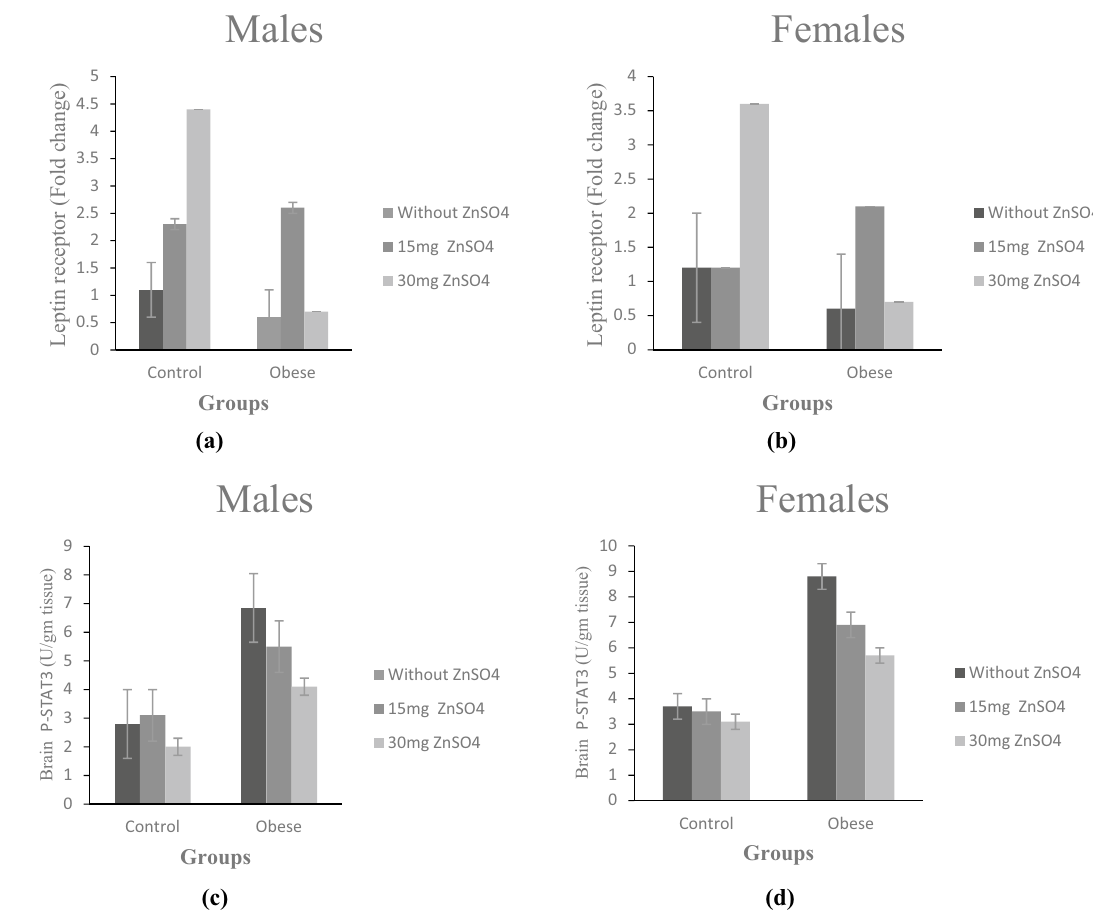
Figure 3. ( a , b ) Fold change in leptin receptor expression in brain tissue in control and obese groups; without ZnSO 4 , 15 mg ZnSO 4 , and 30 mg ZnSO 4 in male and female rats, respectively. ( c , d ) Brain tissues levels of p-STAT3 (U/gm tissue) in control and obese groups; without ZnSO 4 , 15 mg ZnSO 4 , and 30 mg ZnSO 4 ; in male and female rats, respectively. Results are expressed as (mean ±